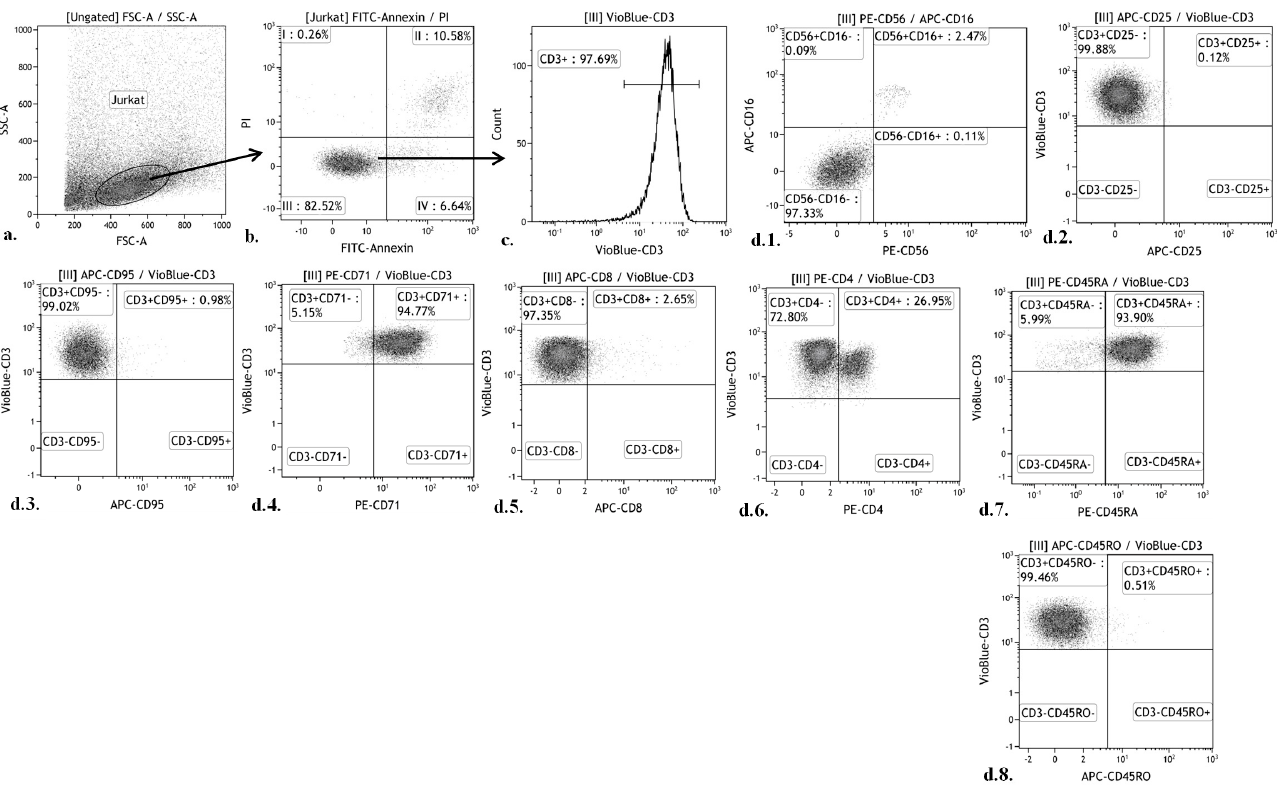
Figure 3. Gating strategy for Jurkat T cell CD staining. ( a ) Jurkat cell gating based on a forward scatter (FSC) vs. side scatter (SSC) plot; ( b ) The analysis was carried out using gating of Jurkat cells. The abscissa axis is the fluorescence intensity of the antibodies against Annexin; the ordinate is the fluorescence intensity of the antibodies against propidium iodide. Area “III” contains viable cells; ( c ) The analysis was carried out using gating on the “III” area. Histogram of the distribution of Jurkat cells; the axis of abscissas is the fluorescence intensity of the antibodies against CD3; the ordinate is the number of cells; ( d1 ) The analysis was carried out using gating of the “III” area. Histogram of the distribution of Jurkat cells; the abscissa axis is the fluorescence intensity of the antibodies against CD56; the ordinate axis is the fluorescence intensity of the antibodies against CD16, ( d2 – d8 ) The analysis was carried out using gating of the "III" area. Histogram of the distribution of Jurkat cells; the abscissa axis is the fluorescence intensity of the antibodies against CD3; the ordinate axis is the fluorescence intensity of the antibodies against CD25, CD95, CD71, CD8, CD4, CD45RA, or CD45RO.